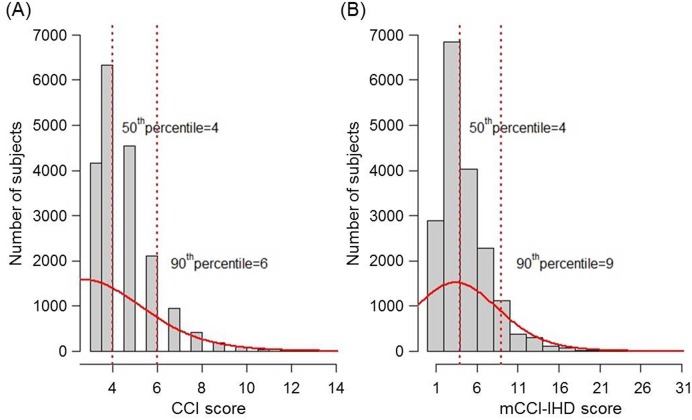
Distribution of the CCI and mCCI-IHD scores for the development cohort.(A) Distribution of the CCI scores (n = 18,872), excluding patients with no comorbidity (n = 5,866). (B) Distribution of the mCCI-IHD scores (n = 18,087), excluding patients with no comorbidity (n = 6,651). The y-axis shows the number of subjects. The solid line represents a density curve, calculated by approximation, to identify the overall pattern and deviation. The vertical dotted lines (red) represents the 50th and 90th percentile values. CCI, Charlson comorbidity index; mCCI-IHD, modified Charlson comorbidity index for incident hemodialysis patients.